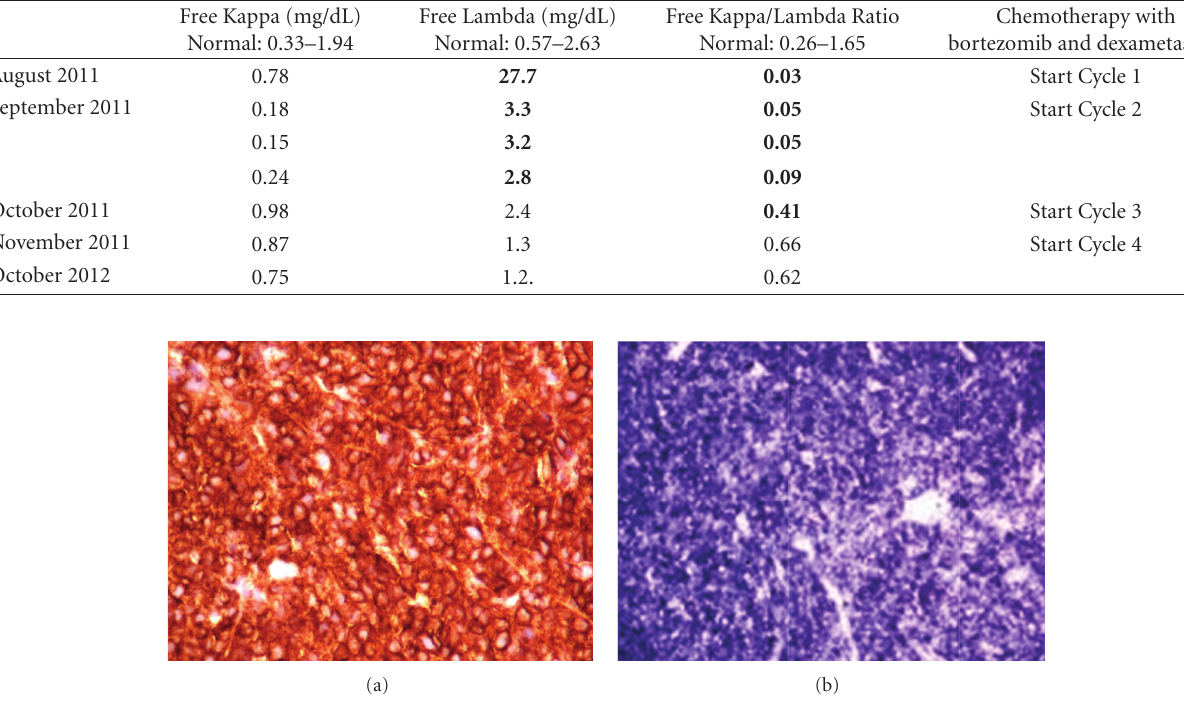
Table 2: Summary of serum free light chains assays.